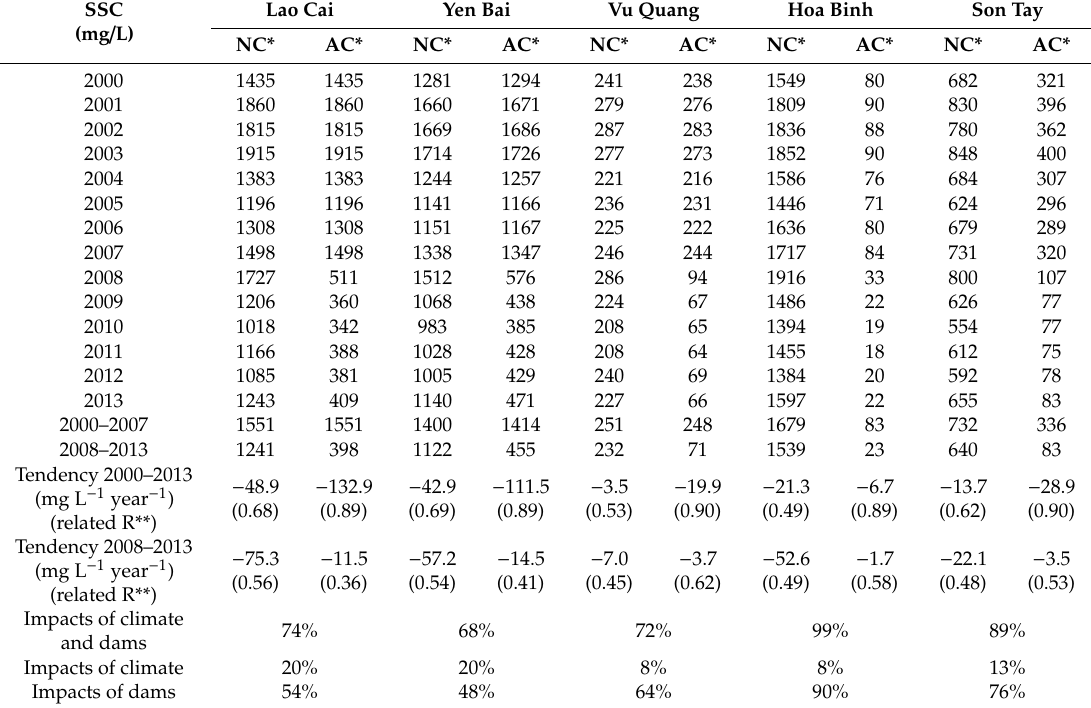
Table 7. Annual mean suspended sediment concentration (SSC) from 2000 to 2013 and the multi-year annual mean SSC of 2000–2007 (before new dams’ constructions) and 2008–2013 (after new dams’ constructions). Variation tendency of annual mean SSC from 2000 to 2013 and 2008 to 2013. Impact percentages of climate variability and